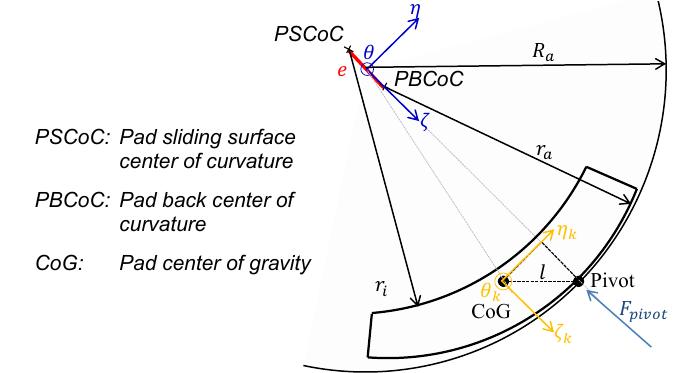
Figure 2. Coordinate system of a single pad. The ( 𝜁, 𝜂, 𝜃 )-coordinate system is located in the bearing center. The 𝜁 -axis is directed to pivot position and the 𝜃 -axis is in parallel to the axial bearing axis. For the description of the tilting motion a body-fixed ( 𝜁 𝑘 , 𝜂 𝑘 , 𝜃 𝑘 )- coordinate system is introduced at the pad’s